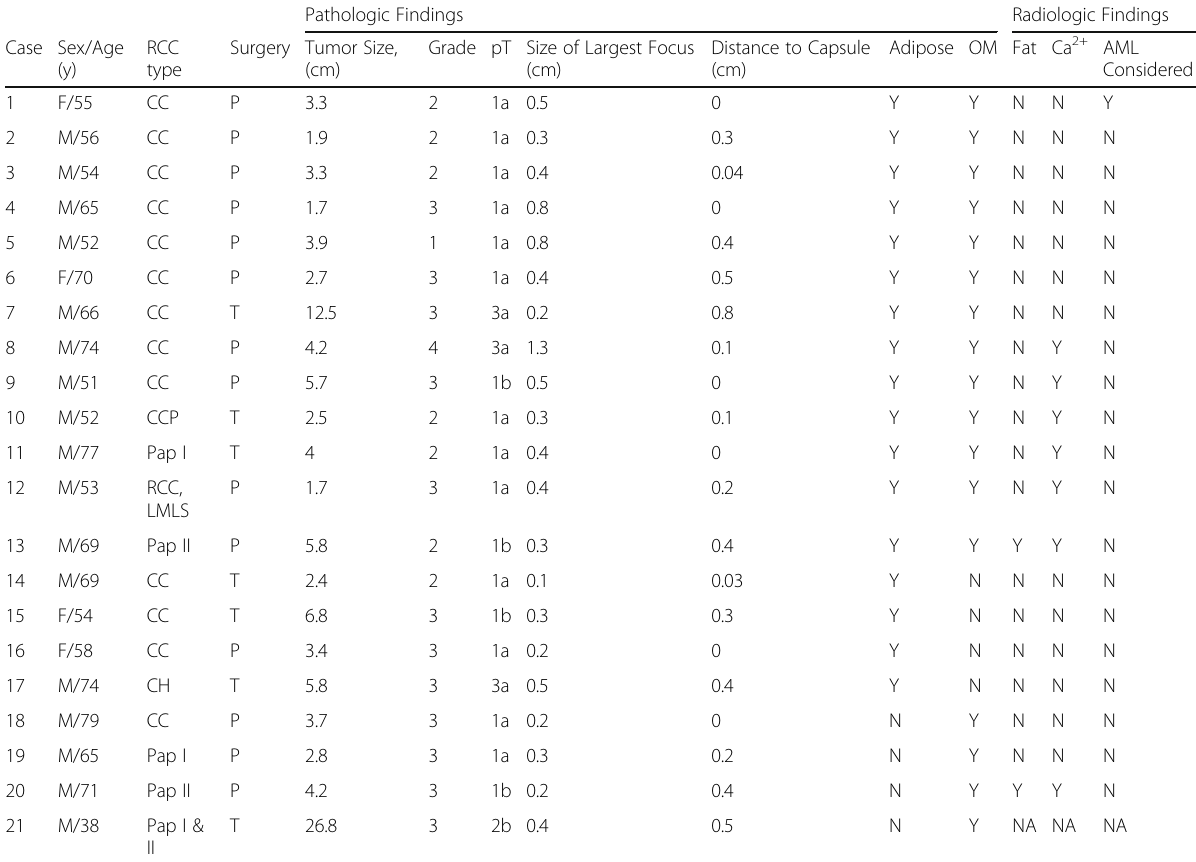
Table 1 Demographic, pathologic, and radiographic characteristics